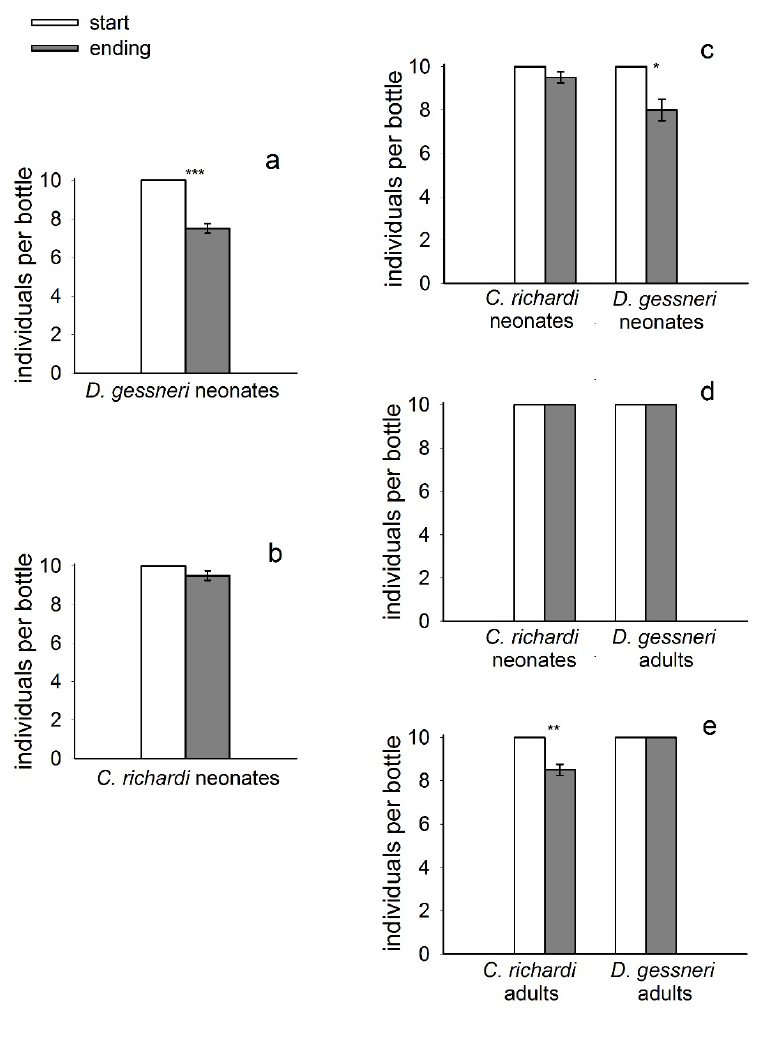
Figure 4. Number of prey of C. richardi (Cr) and D. gessneri (Dg) at the beginning (white) and its average number at the end (grey) of the experiment, after individuals were exposed to predation by Chaoborus brasiliensis ; neonates of Dg (a), neonates of Cr (b), neonates of Cr + neonates of Dg (c), neonates of Cr + adults of Dg (d) and adults of